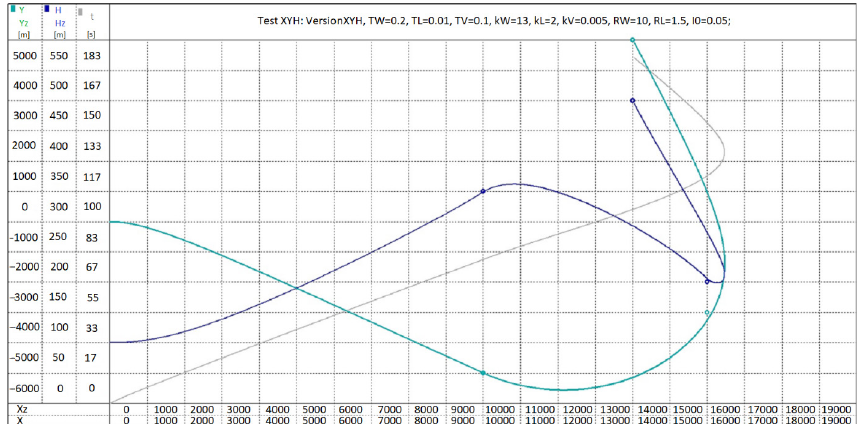
Figure 12. Complex flight manoeuvre to the coordinates of three points on plane Y z and the preset altitudes H z , (350, 200, 500 [m] ) for the coefficient of reinforcement k w = 13 and the derivative constant R w = 10 [s]. UAV at the preset altitude reaches the particular points after approximately 80, 120, 190 [s],